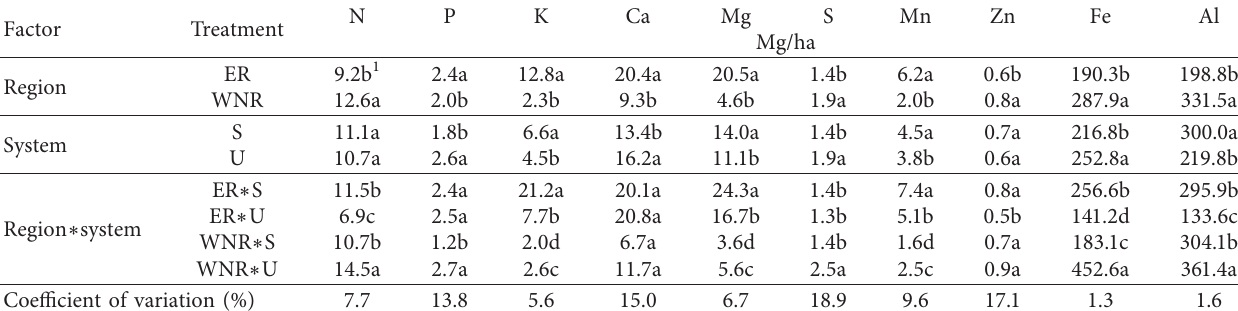
Table 5: Total nutrient stocks in cocoa ecosystems (biomass+soil at 0–60 cm depth) ( n � 3). Factor